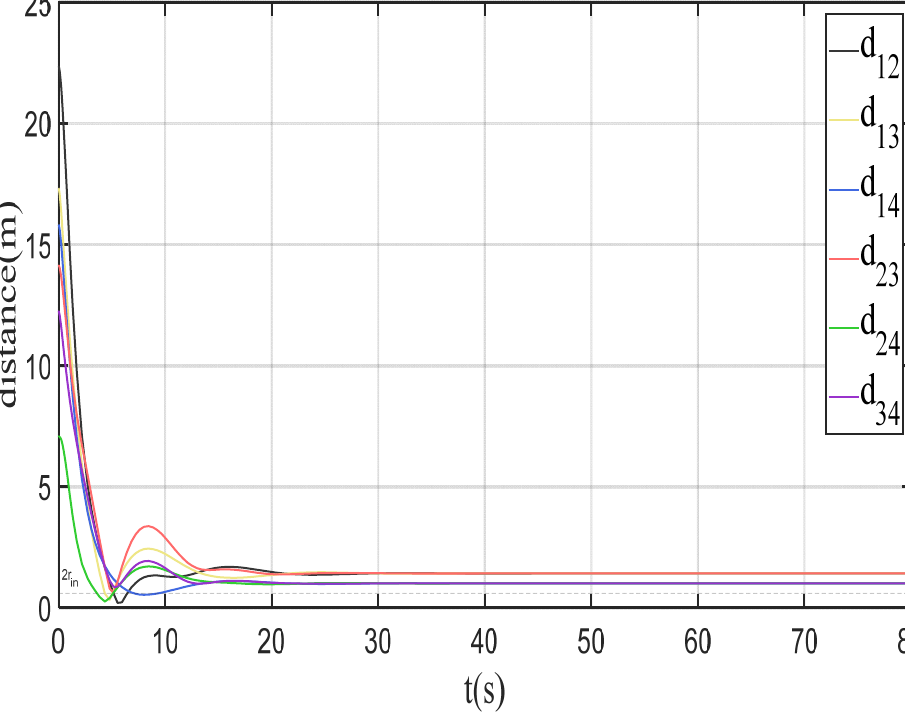
Figure 9. Velocity errors of UUVs in u and v . Figure 10. Velocity errors of UUVs in w , and position errors of UUVs in x direction.